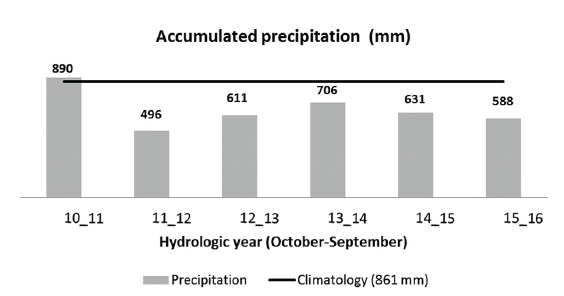
Figure 2 - Accumulated precipitation for the period